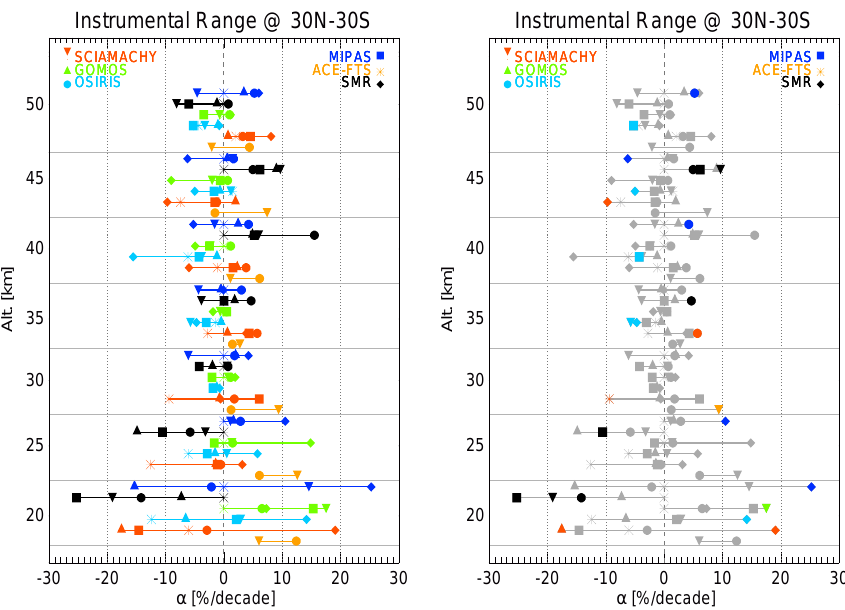
Figure 7. (a) Relative drift ( α ) range for all sensors as a function of altitude in the tropical band (30 ◦ S–30 ◦ N). Reference sensors are indicated by colour and individual comparison sensors by corresponding symbols. (b) Same as (a) but only significant α values are shown (non-significant values are shaded